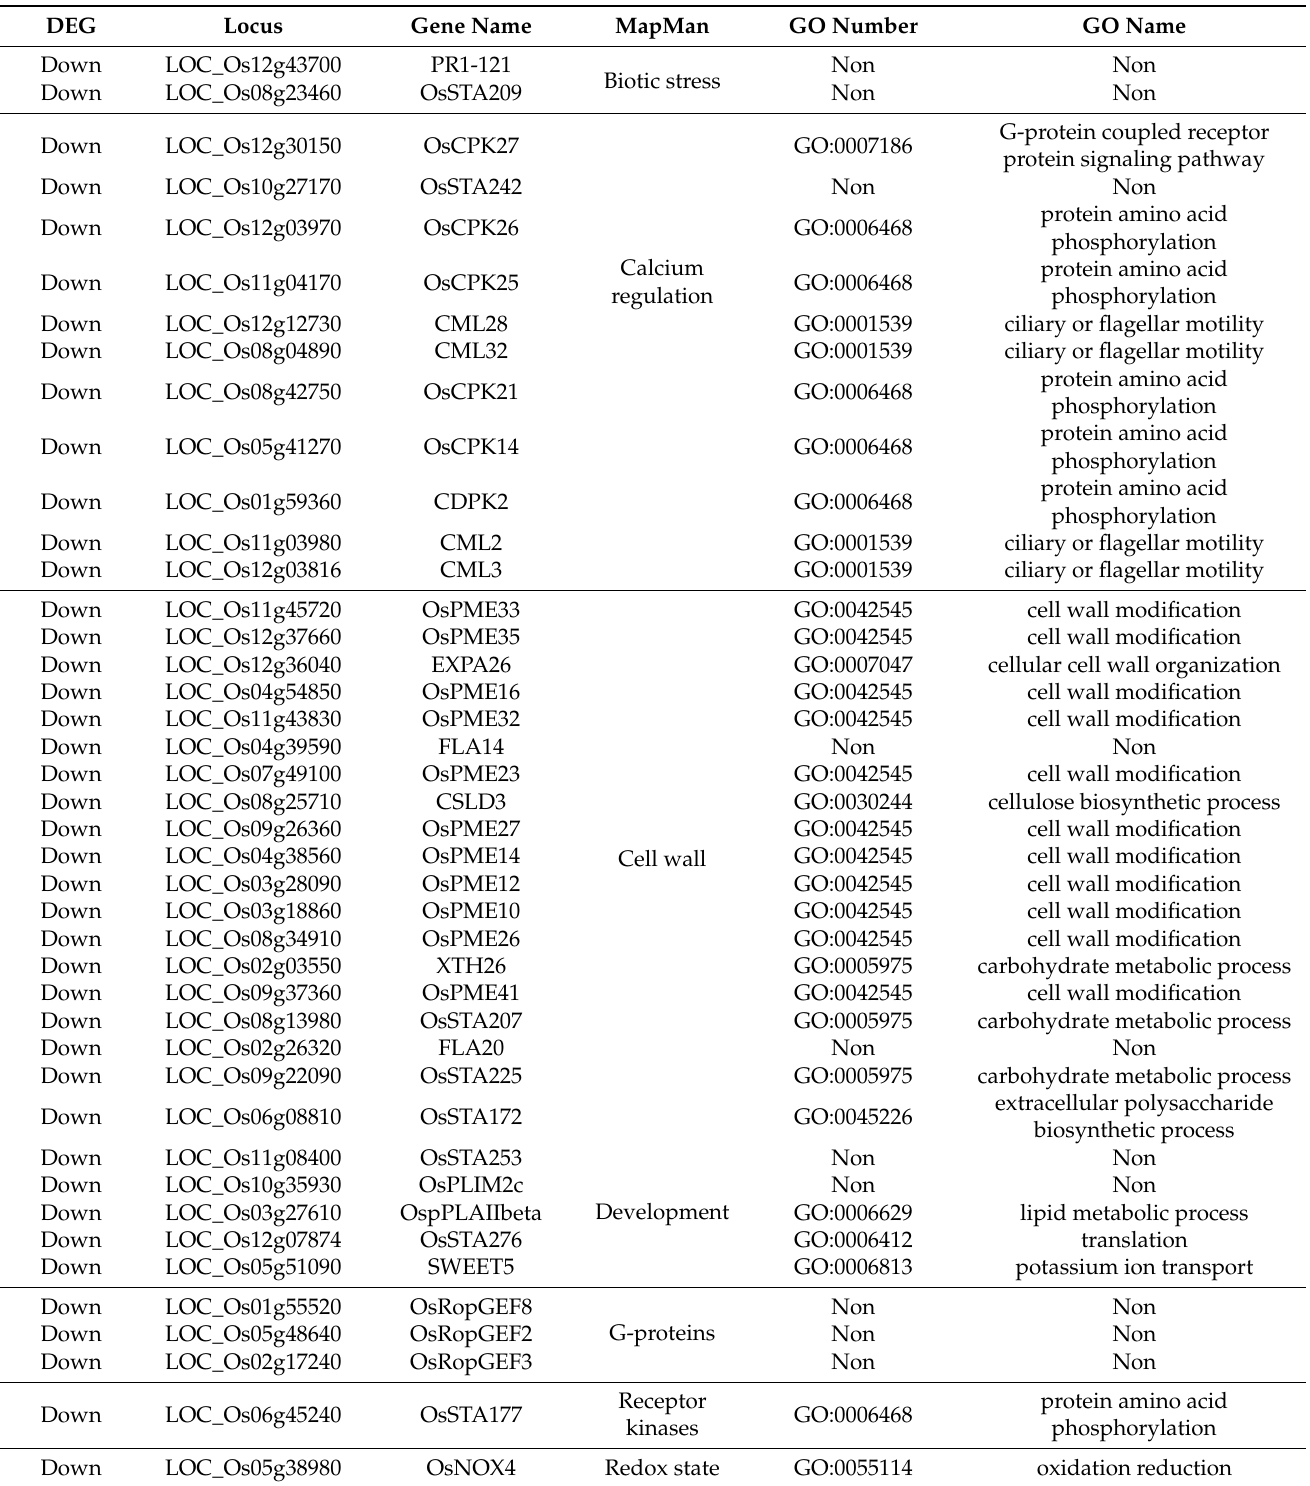
Table 1. The GO annotation and MapMan analysis of known genes in anther downregulated genes of